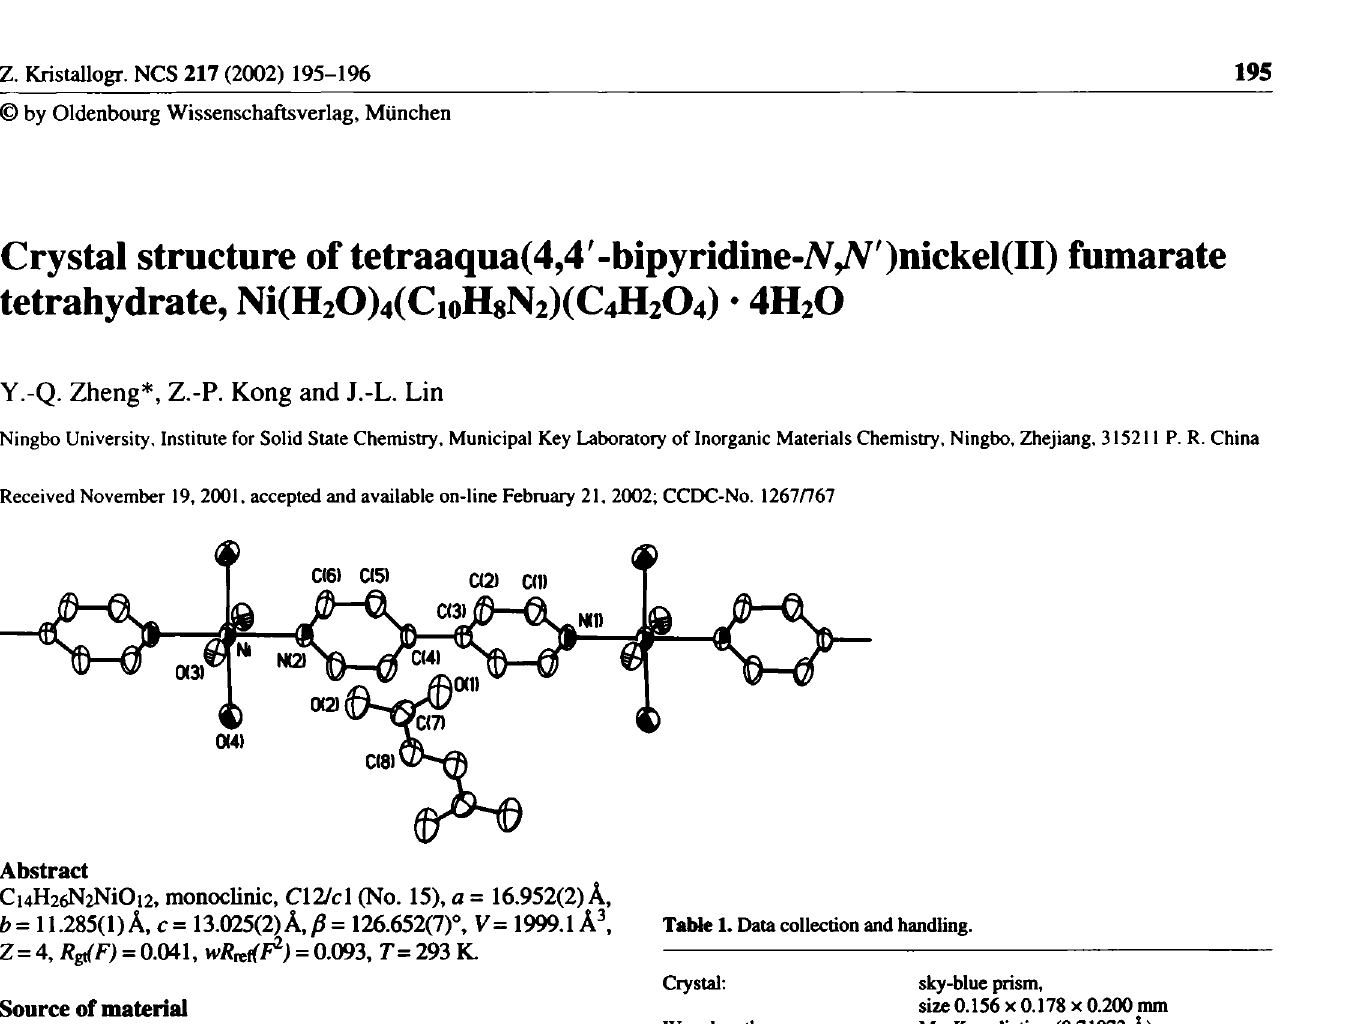
Table 2. Atomic coordinates and displacement parameters (in À 2